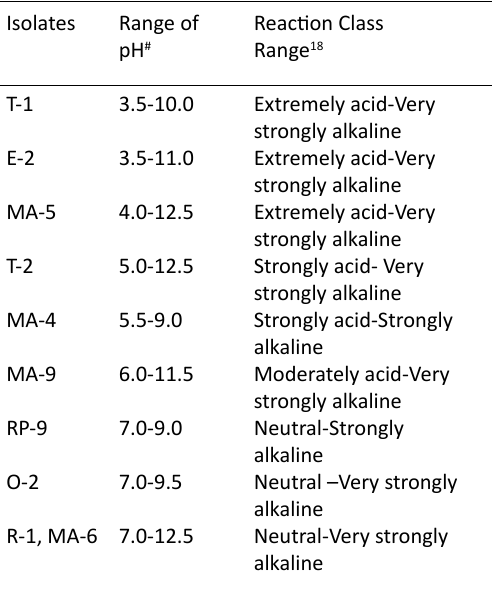
Table 5. Reaction class range classification of PGPB isolates